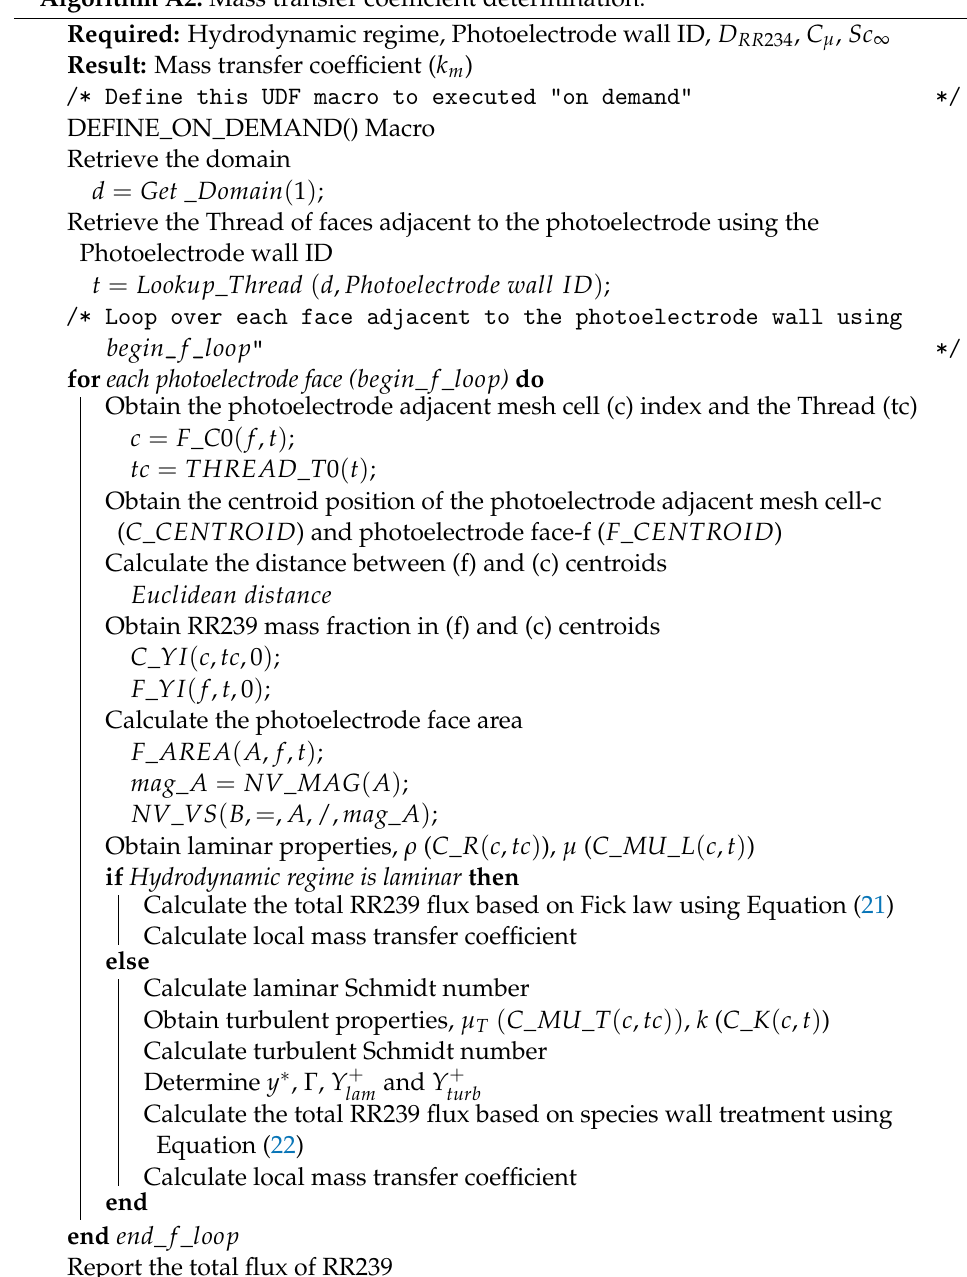
Algorithm A2: Mass transfer coefficient